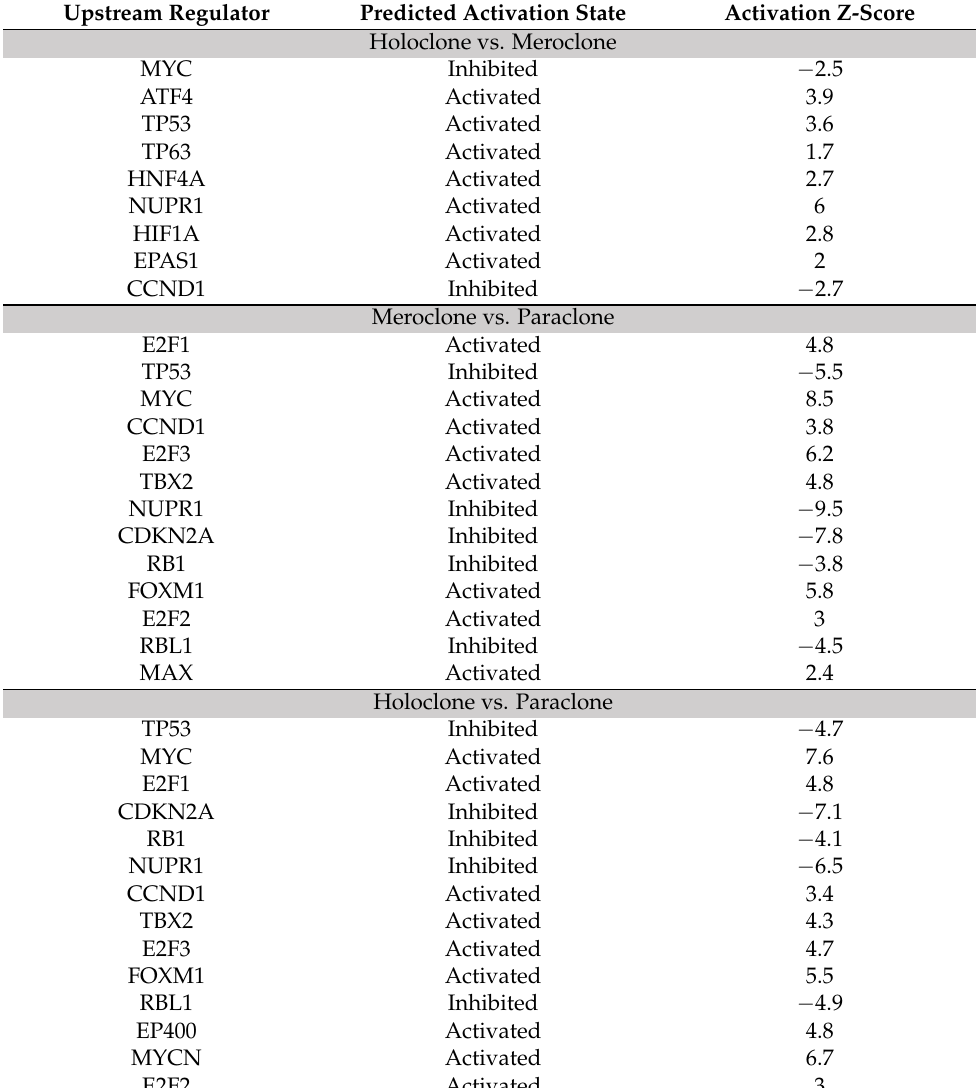
Table 3. Transcription regulators predicted to be activated/inhibited by ingenuity pathway analy- sis